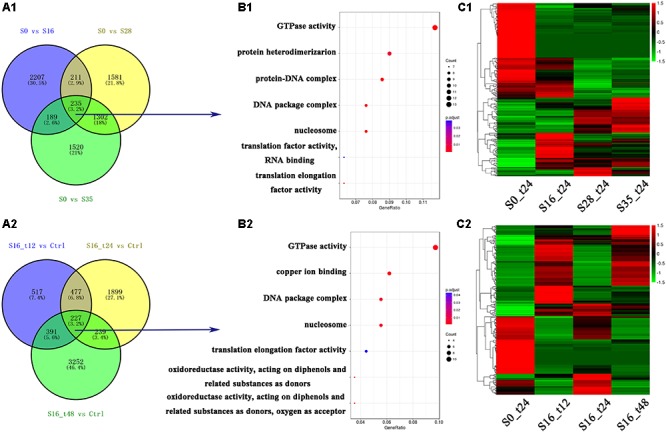
Grouping and enrichment analysis of differentially expressed genes. (A1) Grouping of the differentially expressed genes in S16_t24, S28_t24, and S35_t24 groups. (A2) Grouping of the differentially expressed genes in S16_t12, S16_t24, and S16_t48 groups. (B1) Enrichment analysis of the 235 differentially expressed genes shared by the gene lists in S16_t24, S28_t24, and S35_t24 groups. (B2) Enrichment analysis of the 277 differentially expressed genes shared by the gene lists in S16_t12, S16_t24, and S16_t48 groups. (C1) Cluster map of the differentially expressed genes in the S16_t24, S28_t24, and S35_t24 groups. (C2) Cluster map of the differentially expressed genes in the S16_t12, S16_t24, and S16_t48 groups.